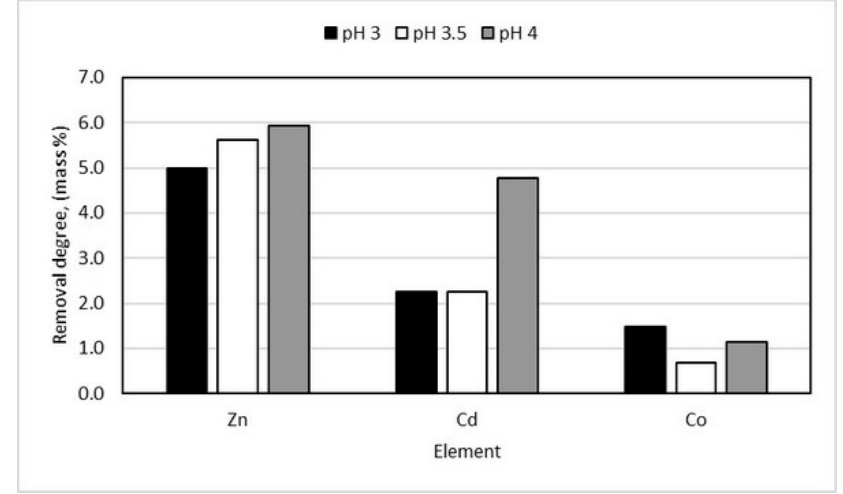
Figure 3. Dependence of Zn, Cd, and Co removal degree of pH value.